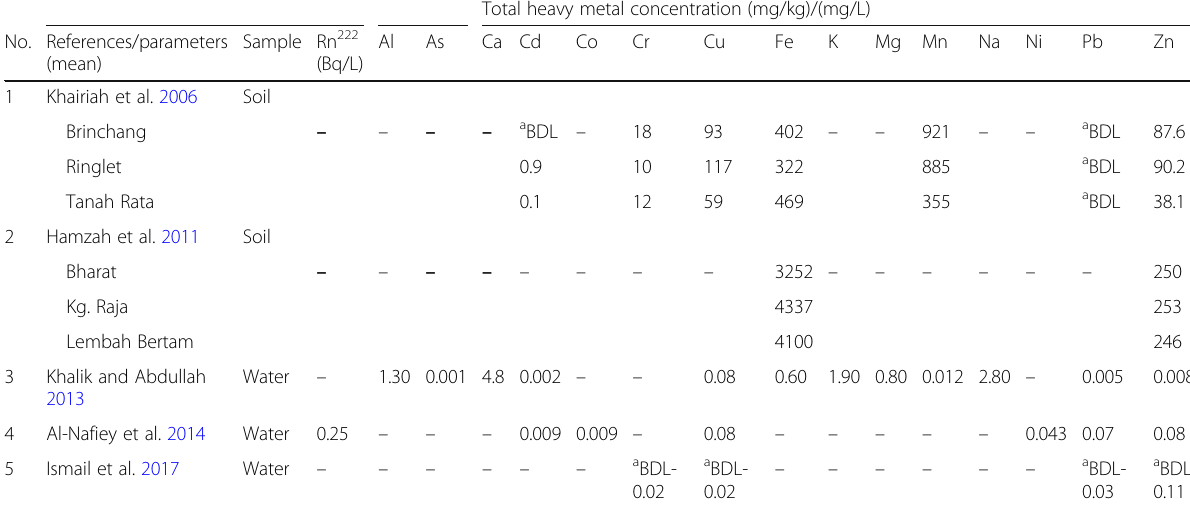
Table 4 Comparison of heavy metals concentration in water (mg/L) of rivers and tributaries and in agricultural soils (mg/kg) of selected farms in Cameron